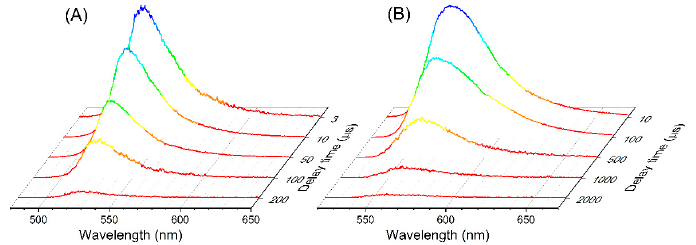
Figure 2. Time-dependent fluorescence emission spectra of PM546 in ethyl acetate ( A ) and PM556 in DMSO ( B ) measured under ambient conditions. Optically matched solutions at 532 nm were used.